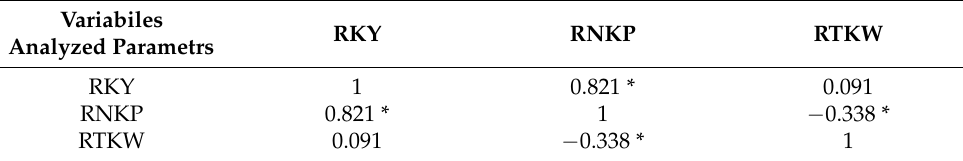
Table 2. Correlation coefficients between kernels yield reduction (RKY), number of kernels per panicle reduction (RNKP) and 1000 kernels weight reduction (RTKW), on average over 3 years of research